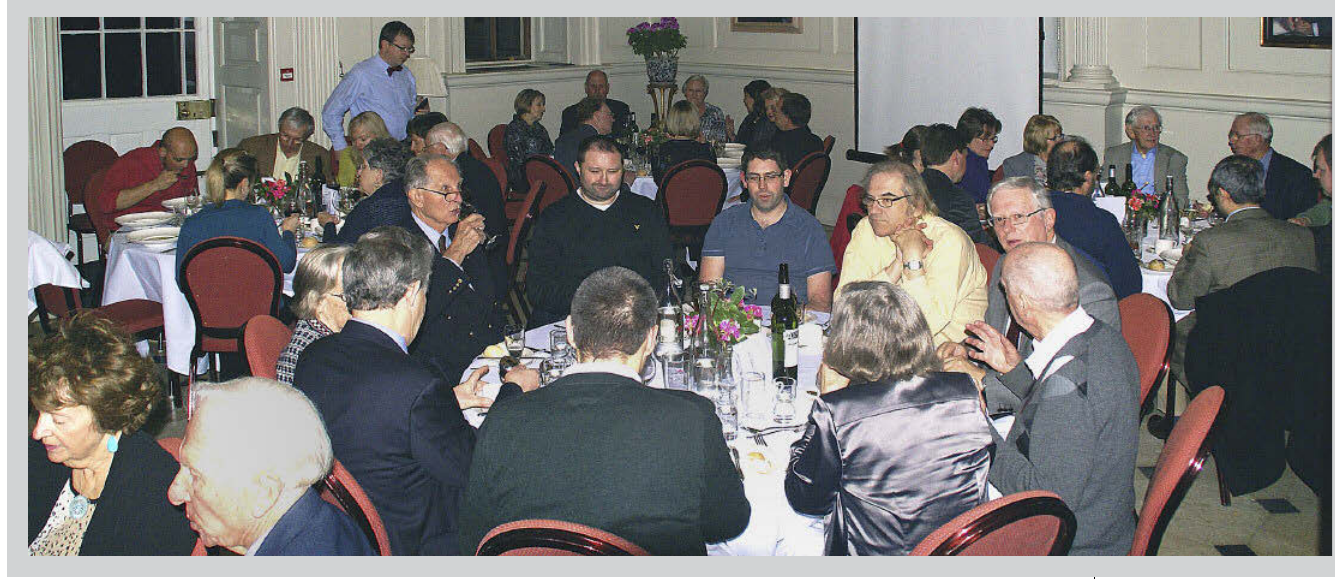
Figure 5: Evening meal at Chicheley